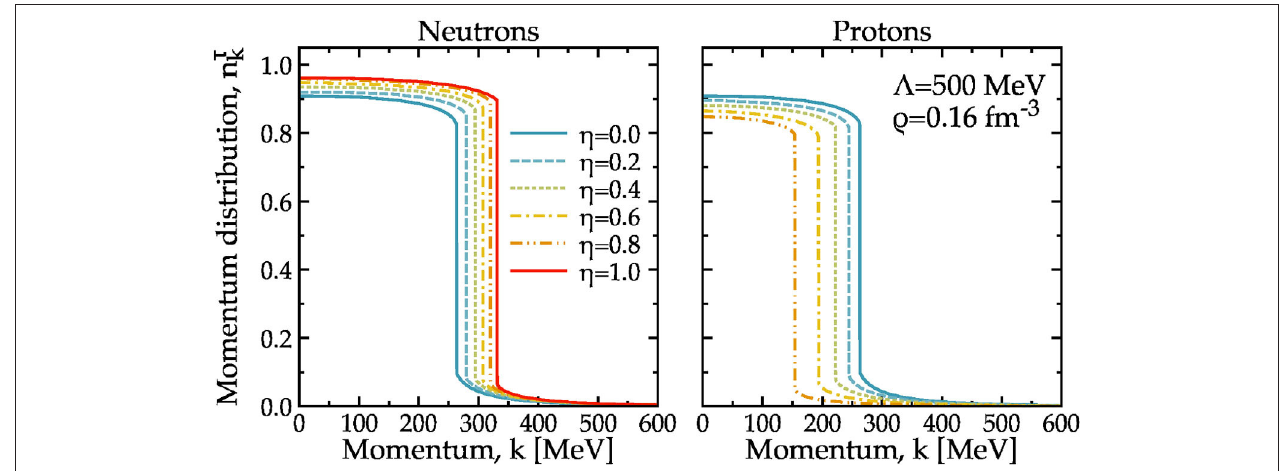
FIGURE 8 | Left : neutron momentum distribution n n k as a function of momentum. Extrapolated zero-temperature calculations at different values of isospin asymmetry η are shown at a fixed density of ρ = 0.16 fm − 3 . Results have been obtained for the 3 = 500 MeV interaction including 3NFs. Right : the same for the proton momentum distribution n p k